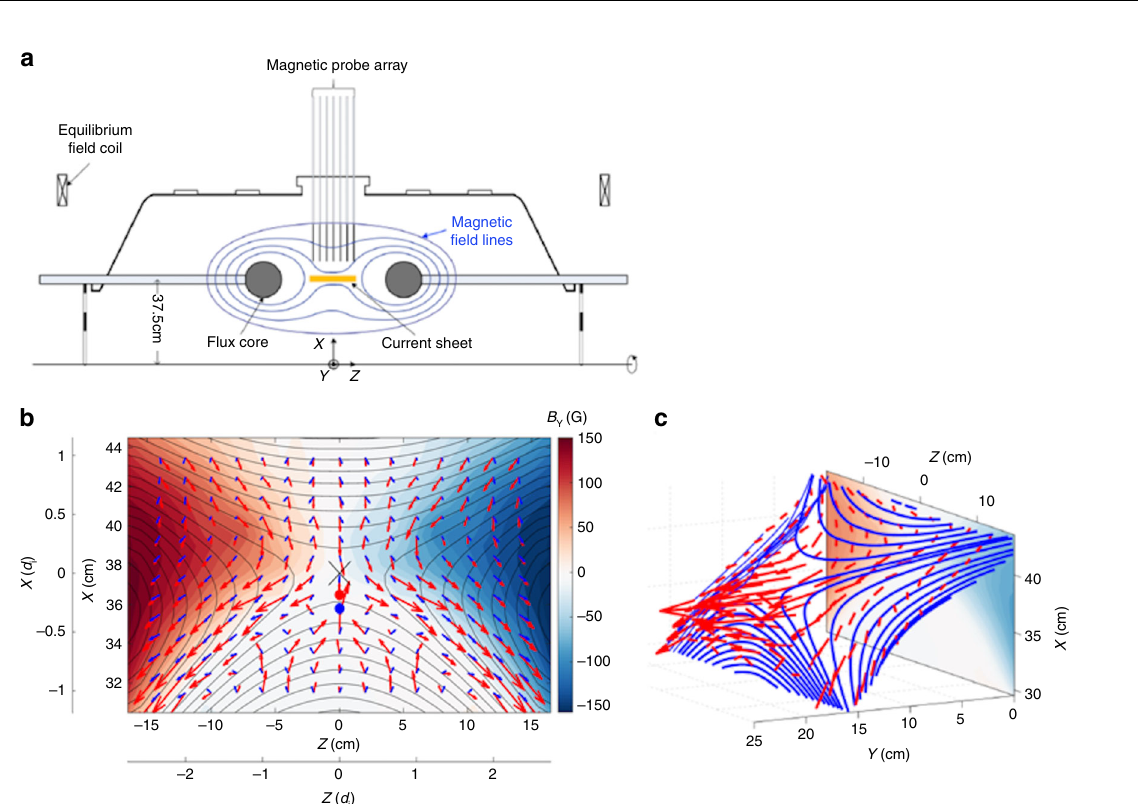
The ion and electron skin depths are based on the density on the high-density (magnetosheath) side. The plasma beta is the ratio of the plasma pressure ( p ) to the local magnetic pressure; β = p /( B 2 / 2 μ 0 ). Note that S »1 is satis fi ed for ideal MHD to be valid globally in both